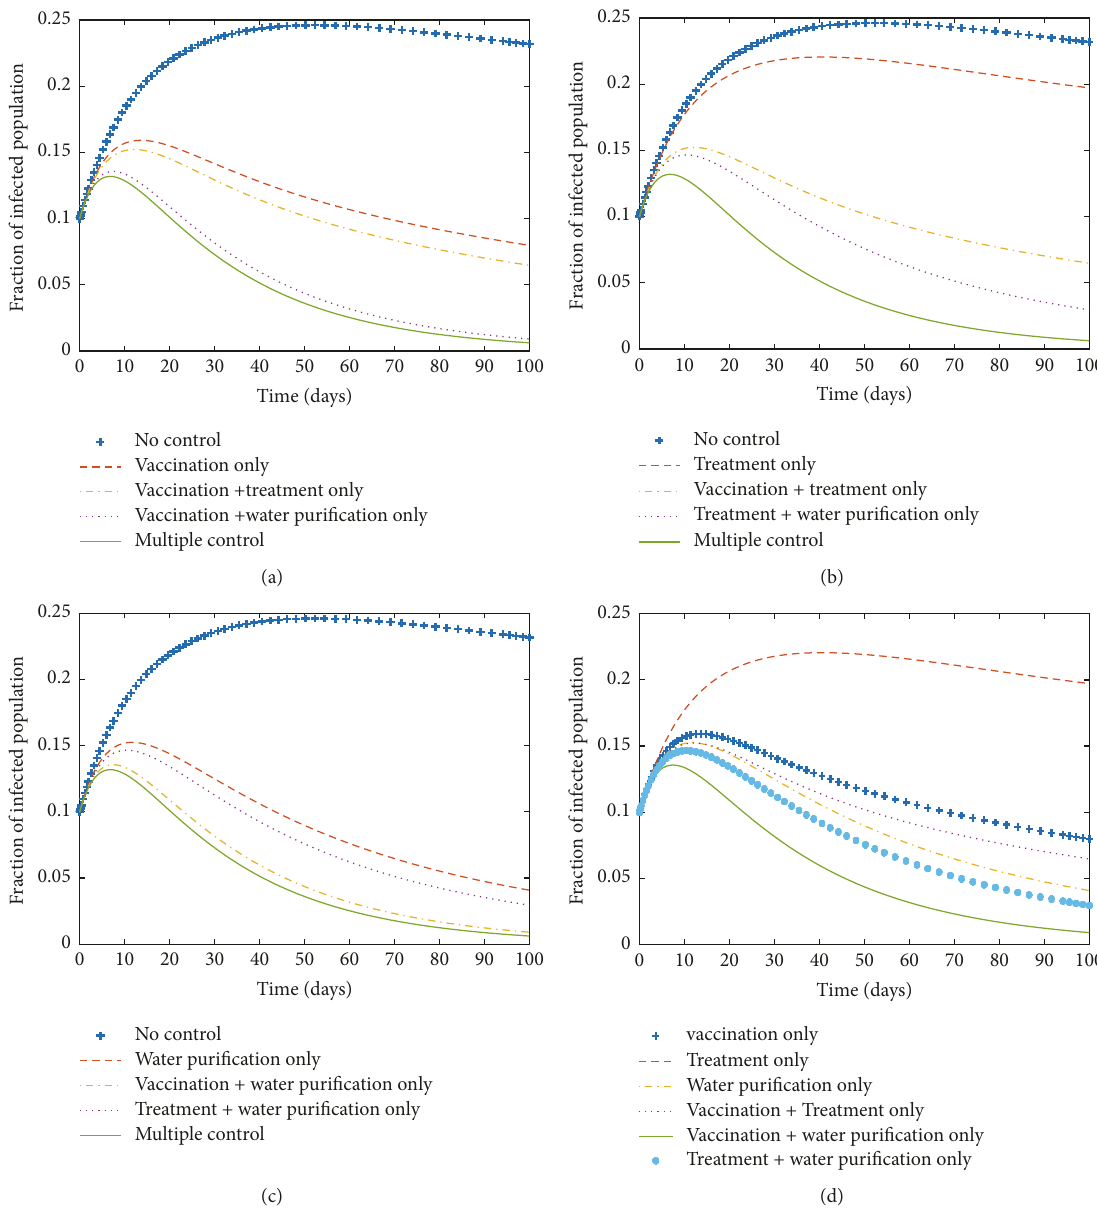
Figure 1: Graphical illustration of the impact of considering a single control, double control, or multiple (three) control measures in reducing the spread of waterborne diseases for different combinations of control